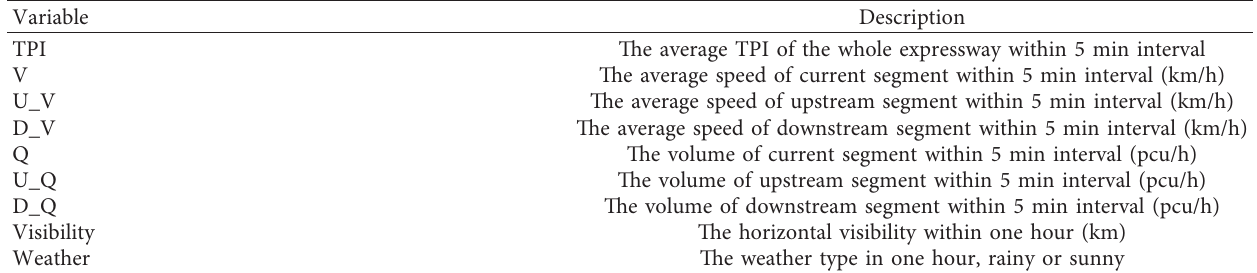
Table 1: Information of the nine alternative